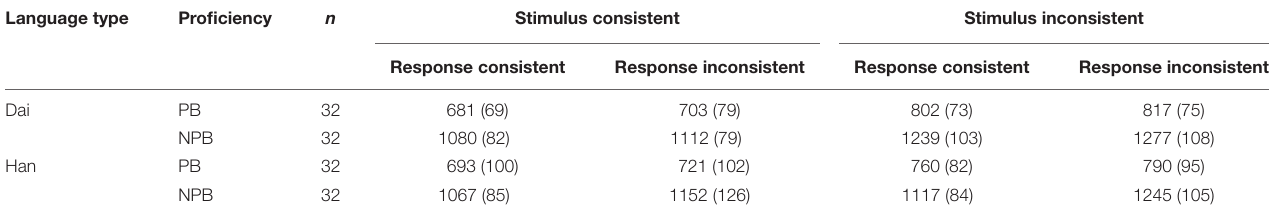
TABLE 1 | Means and standard deviations of participants, RTs in different experimental conditions (ms). Language